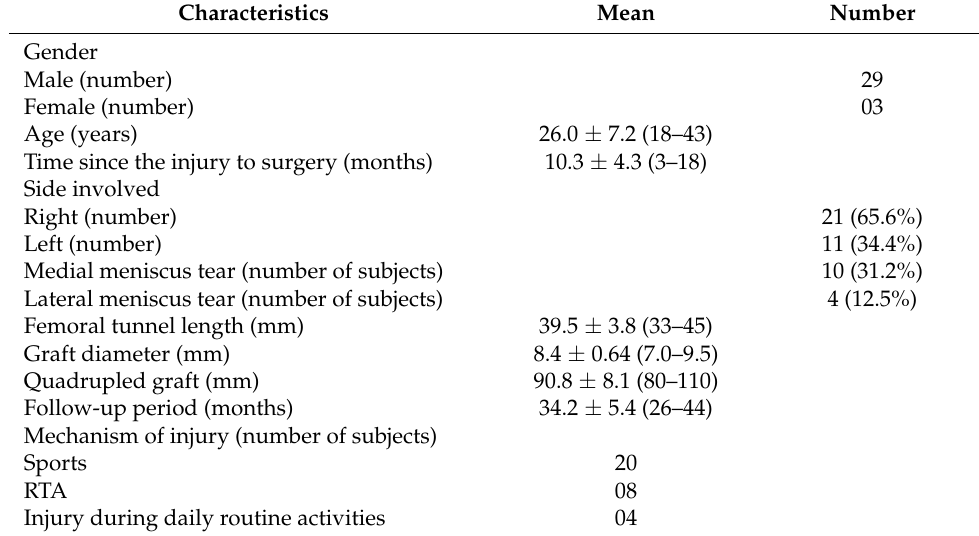
Table 1. Demographic properties of the participants involved in the study.